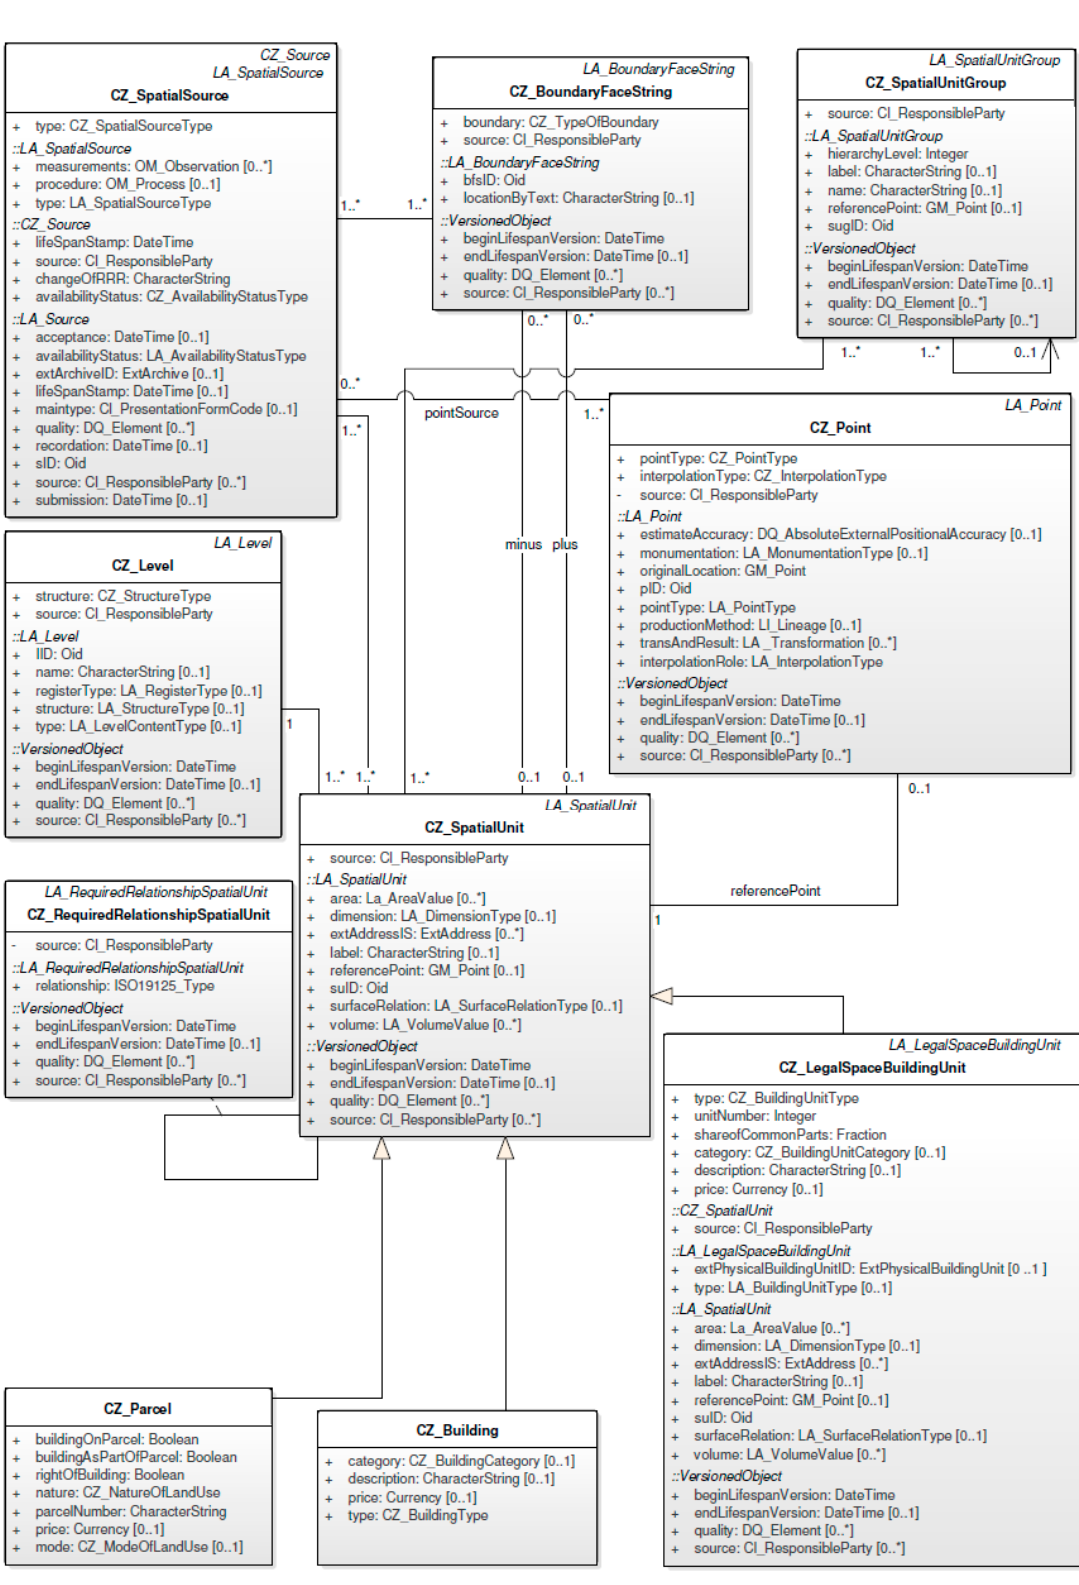
Figure 9. Overview of the spatial component of the Czech country profile.